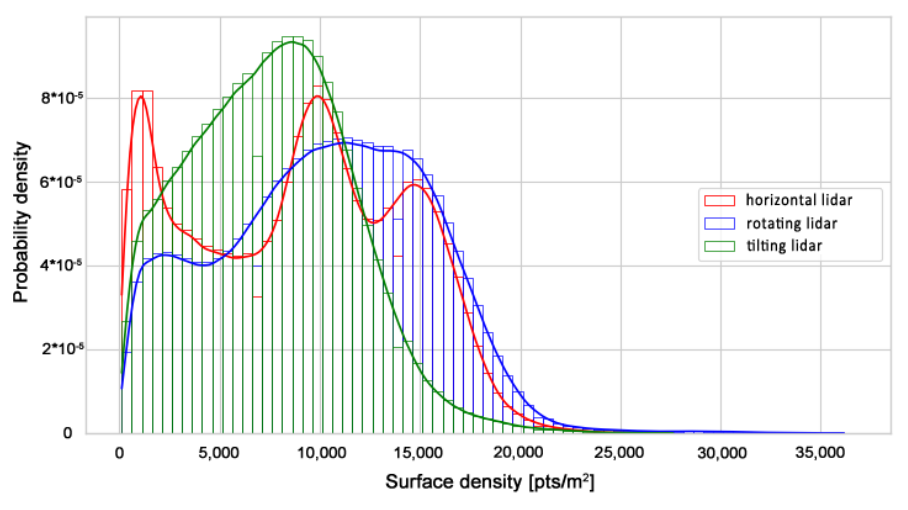
Figure 12. Distributions of surface densities per